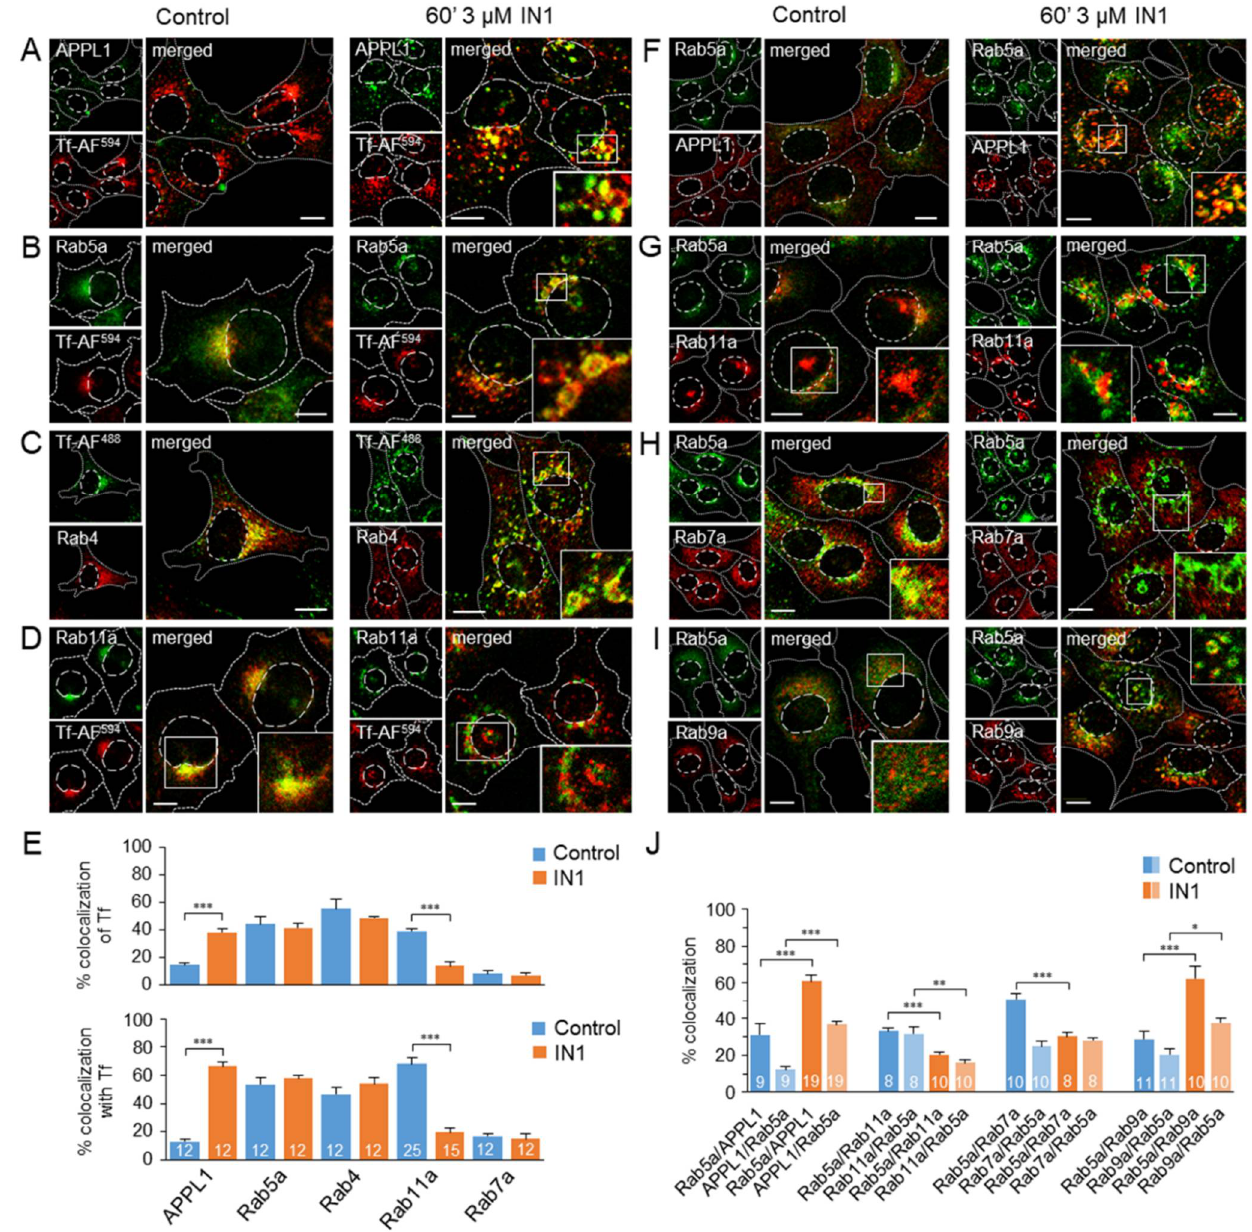
Figure 3. Co-localization analysis of internalized Tf ( A – E ) and Rab5a ( F – J ) in PI3P-depleted cells. ( A – D ) Colocalization of internalized Tf with APPL1, Rab5a, Rab4, and Rab11a in control and IN1-treated cells. Balb 3T3 cells were treated with either 3 μM VPS34-IN1 (IN1) or tissue culture medium containing DMSO (control) for 60 min and incubated with either Tf-AF 488 or Tf-AF 594 for 45 min in the presence of the inhibitor. Steady-state organelles were visualized on fixed and permeabilized cells using Ab reagents against cellular proteins that characterize the maturation steps of the membranous organelles. The antibody reagents used are listed in Table S1, and each marker is described in Table S2. Shown are the representative confocal images. The insets show a zoomed area box. Cell borders are indicated by fine dotted lines and cell nuclei by fine dashed lines. Bars, 10 μm. ( E ) 3D colocalization of Tf with organelle markers (upper panel) and organelle markers with Tf (lower panel) is based on the M1/M2 coefficients of pixel overlap measured over the Costes-algorithm thresholded z-stacks of confocal images. Data are mean ± SEM per cell (number of cells indicated in bars). Statistical significance was determined using Student’s t-test (*** p ˂ 0.001). ( F – I ) Representative images ( n = 8–12) of Rab5a and membranous organelle markers in control and IN1-treated Balb 3T3 cells. Insets show zoomed area box. Cell borders are indicated by fine dotted lines and cell nuclei